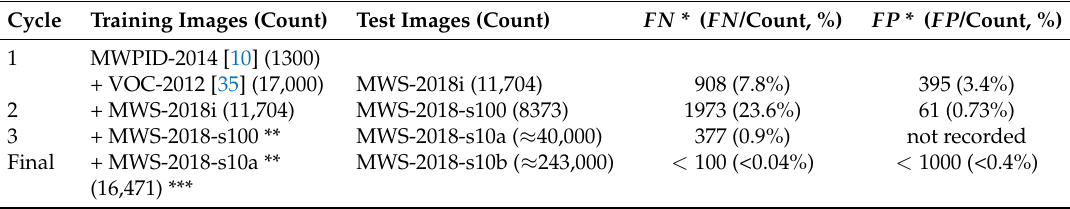
Table 2. Results of the train-predict